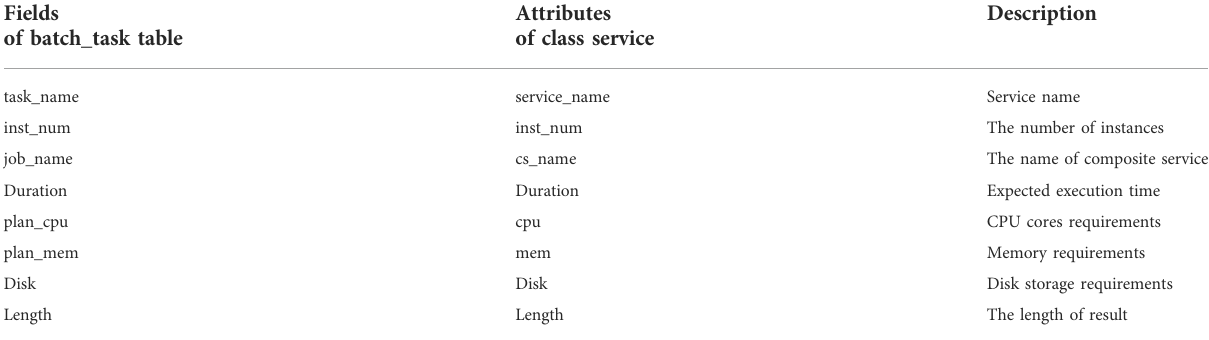
TABLE 2 Table of data relation comparison.